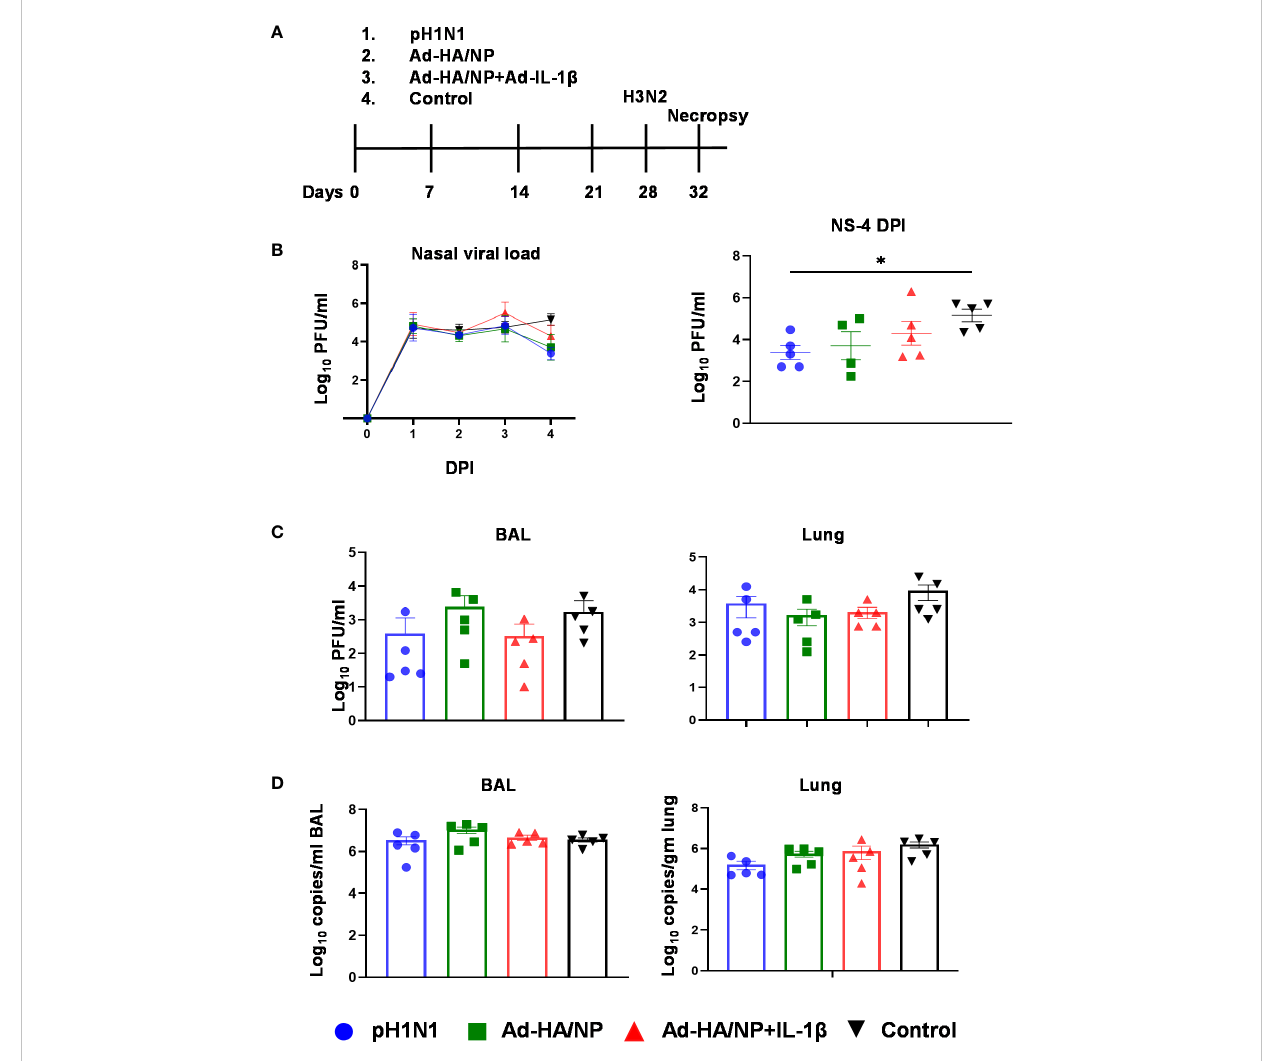
FIGURE 4 Experimental design of heterologous challenge study and viral load in nasal swabs, BAL, and lung. (A) Outbred pigs were intranasally infected with the pH1N1 or immunized with Ad-HA/NP or Ad-HA/NP + Ad-IL-1 b or an empty vector as control. At 28 days post-infection or immunization, all pigs were challenged with the H3N2 virus and were culled 4 days later. Following H3N2 infection, nasal swabs (NS) were taken at 0, 1, 2, 3, and 4 DPI. (B) Virus load in daily nasal swabs and at day 4 post-infection (C) Virus load in BAL and lung assessed by plaque assay or (D) by RT-PCR. All values represent the mean ± SEM of fi ve pigs per group (n=5). Statistical signi fi cances were analyzed by two-way ANOVA followed by Tukey ’ s Multiple Comparison Test on viral load over time (B) and Kruskal-Wallis test with Dunn ’ s multiple comparison test on (C, D) . Asterisks denote signi fi cant differences *, p<0.05 pH1N1 vs.